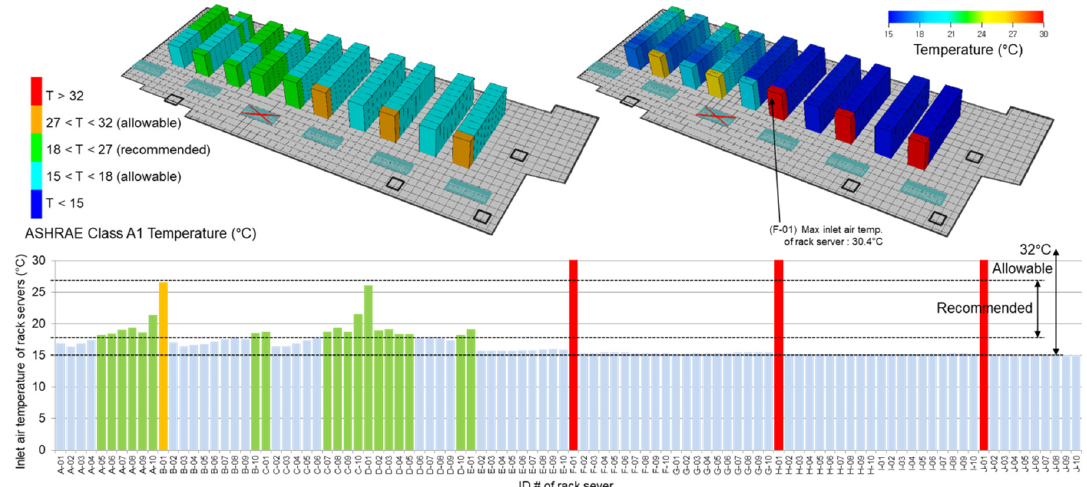
Figure 15. ALT-4 HAC with hard floor — the mean inlet air temperature of 100 server racks in cooling fault condition.